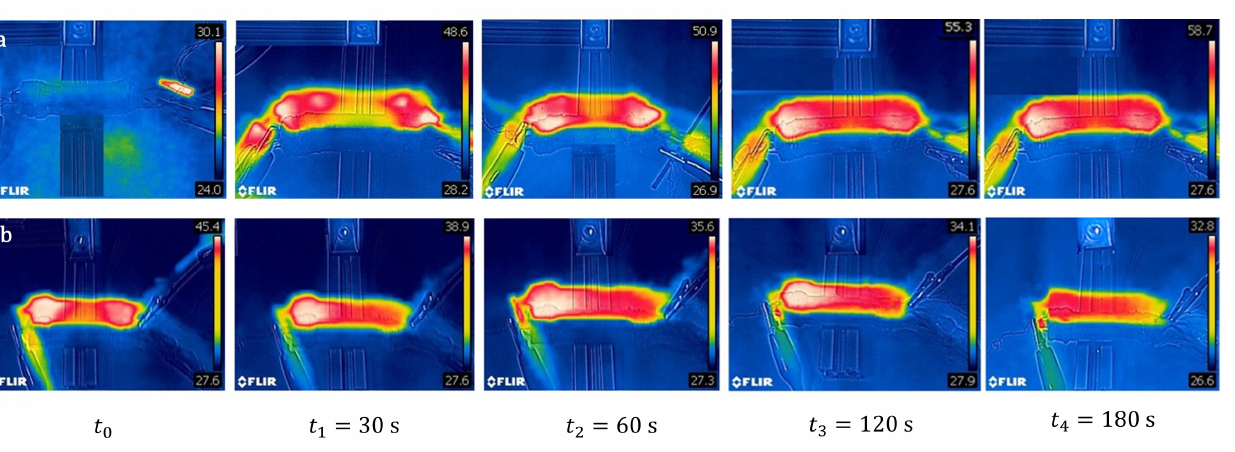
Figure A2. Qualitative thermal analysis of the LMPA module during the transition from ( a ) the stiff to the soft state ( b ) the soft to the stiff